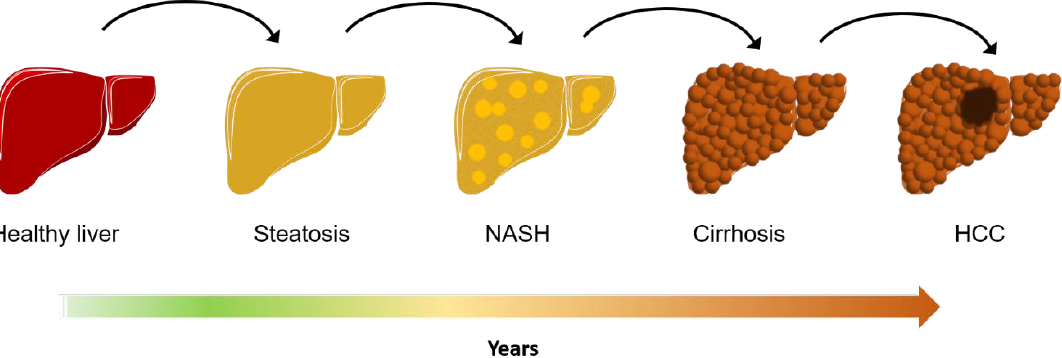
Figure 1. Representation of natural progression of Non-alcoholic fatty liver disease. The global prevalence of NAFLD has been estimated around 25.24% with highest peak of 30.45% in South America, whereas NASH ranges from 3 to 5% globally. These